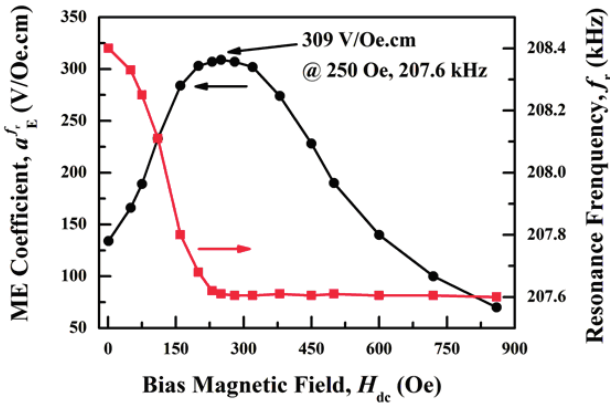
Figure 4. Resonance ME coefficient and the corresponding frequency as functions of the dc bias magnetic field for Permendur/PZT